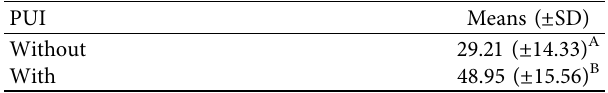
Table 2: Tukey’s test ( α � 0.05) comparison of readings (means (%) and standard deviation ( ± SD)) for the isolated factor PUI.